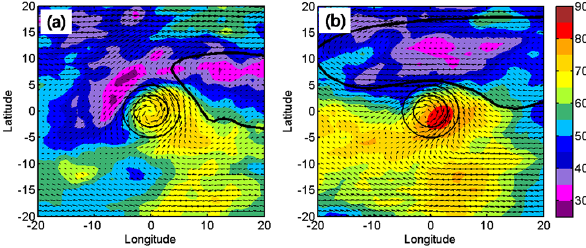
Figure 4. GFS-derived fields for the composites of RH (shading, 5% intervals starting at 25%), vector winds and geopotential height of 5880m at 500hPa (thick black line) at 500hPa for (left) weaken- ing and (right) strengthening events at time t 0h . The two black solid circles are 3 ◦ - and 5 ◦ -radius circles centered on the